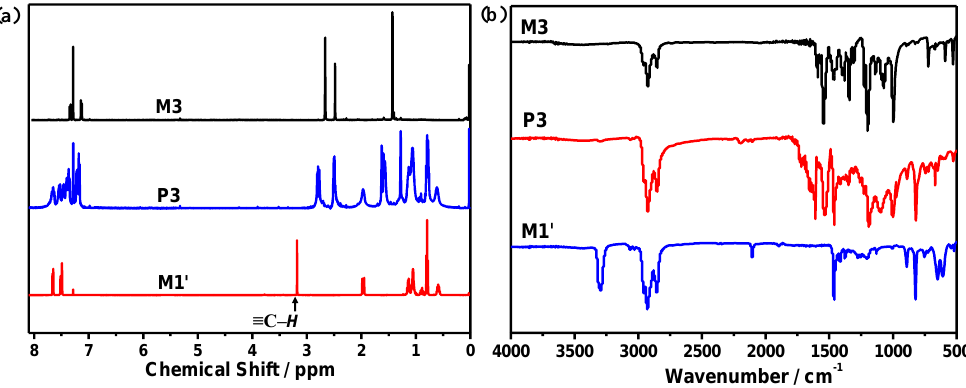
Figure 1. 1 H NMR spectra ( a ); and FT-IR spectra ( b ) of monomers (M1’ and M3) and polymer P3.